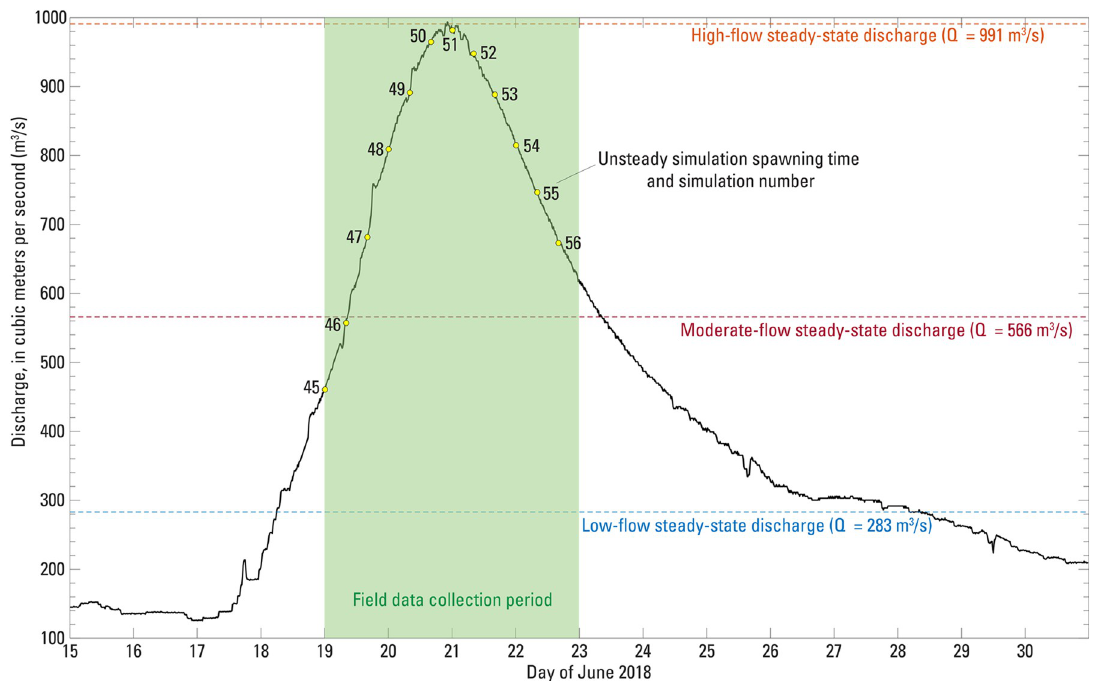
Fig 2. St. Croix River 15-minute discharge record in June 2018, as measured at St. Croix Falls, Wisconsin, (U.S. Geological Survey streamgage 05340500; [42]). The field data collection period (green patch), discharge values used for steady-state hydraulic model simulations (dashed lines), and spawning times for unsteady simulations (yellow dots) are also shown for